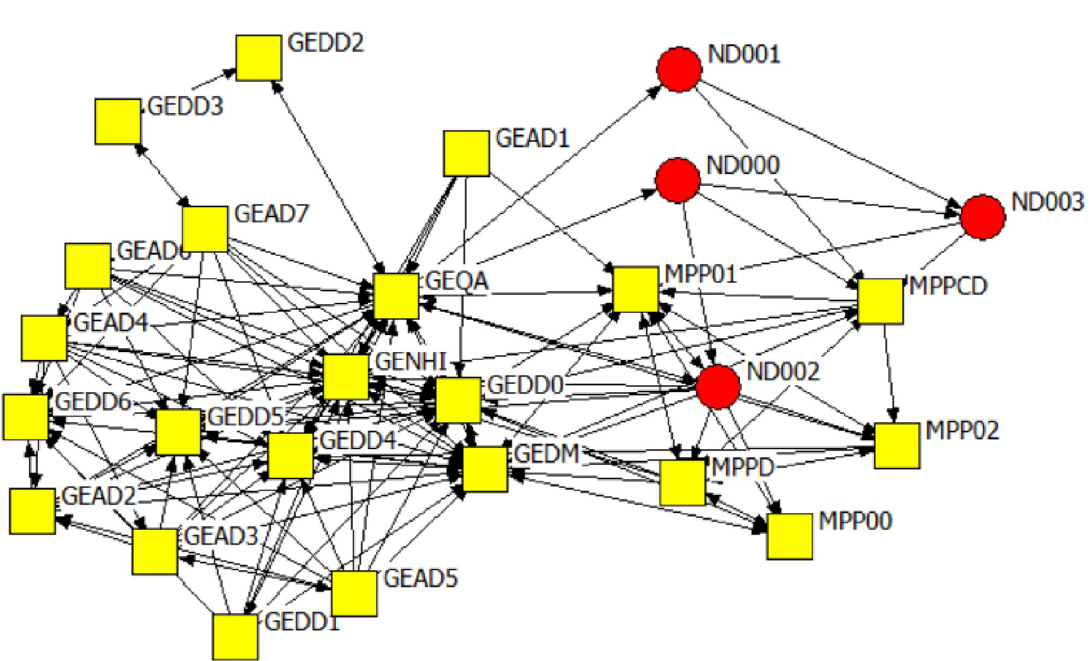
Fig 7. Mpumalanga province network: Providing support. Colour and Shape of the nodes: red circle = National, yellow square = Provincial. Nodes label: ND = A label starting with ND refers to national actors, MP & GE = A label starting with MP or GE refers to provincial